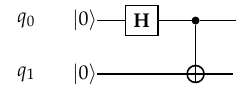
Figure 8. A simple local updating circuit for a supercell comprising two